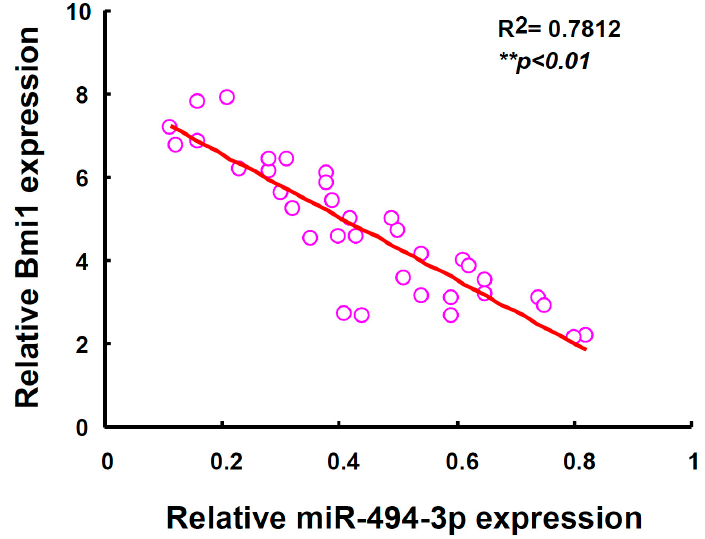
Figure 6. The negative correlation between miR-494-3p and Bmi1 expression in HNC patients. Total RNA were extracted from tumor tissues of head and neck cancer (HNC) patients ( n = 35) and the expression of Bmi1 and miR-494-3p was determined by qRT-PCR methods and analyzed with Spearman rank correlation test.